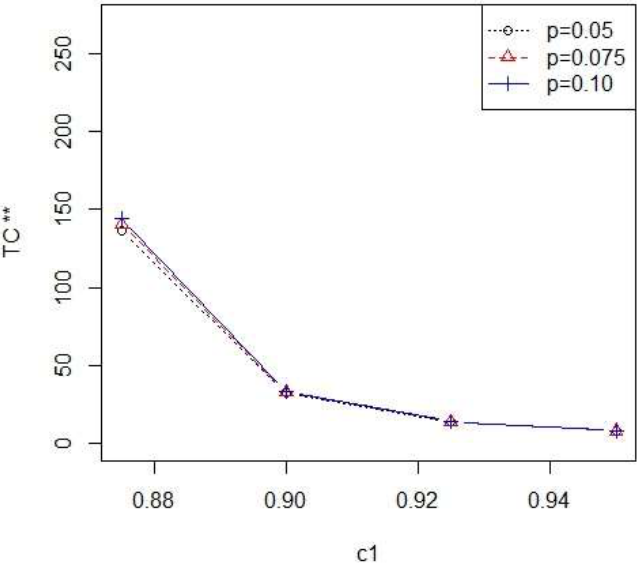
Figure 8. Minimum total cost curve for 1-β = 0.75, 0.80, 0.85 at α = 0.1 and p = 0.05.